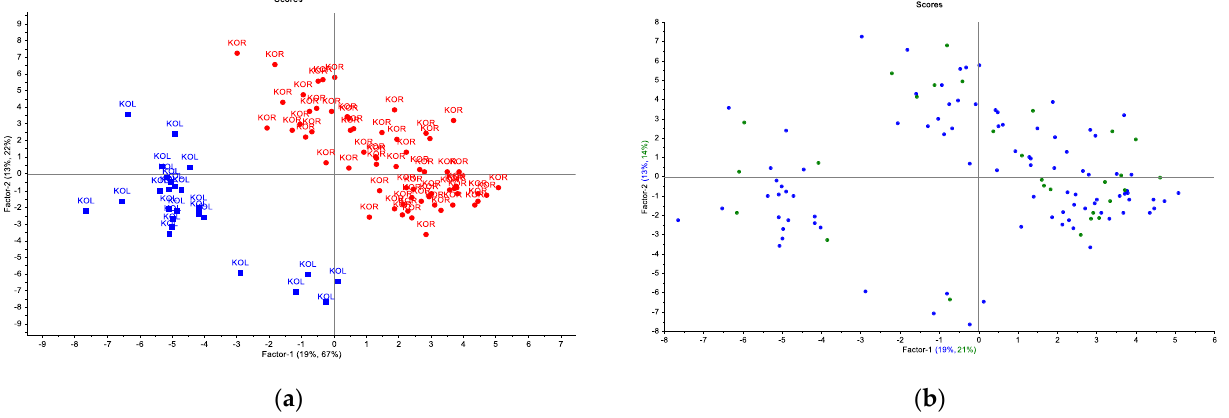
Figure 3. Scores plot of EVOO samples obtained from partial least squares discriminant analysis (PLS − DA) using ( a ) full − cross validation (red circles: Koroneiki; blue squares: Kolovi cultivar) and ( b ) external validation (blue dots: calibration samples; green dots: validation samples).